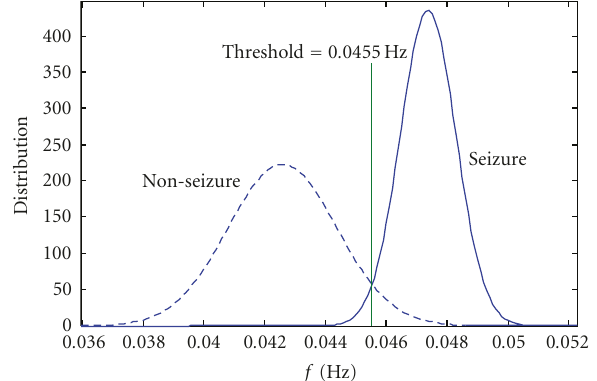
Figure 7: The Gaussian distribution to determine threshold for central/mean frequency in LF.